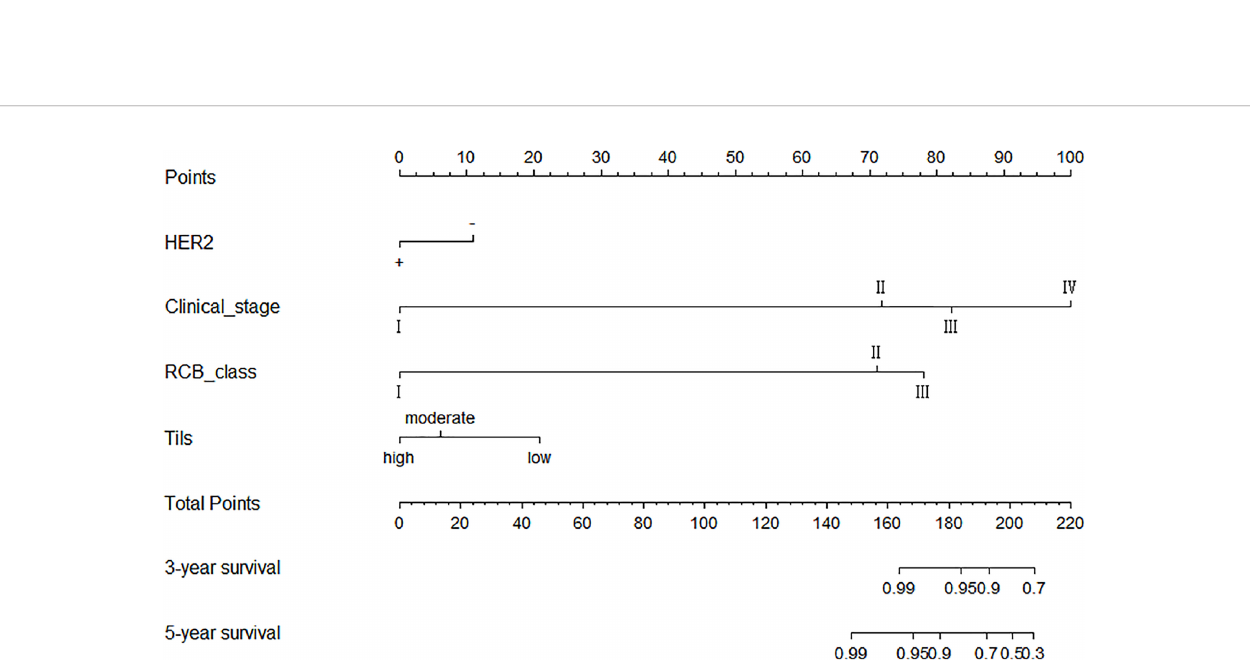
FIGURE 2 | Kaplan-Meier curve of different independent prognostic factors. Multivariate analysis showed that (A) clinical stage, (B) HER2, (C) RCB grading, and (D) Tils were correlated with OS in non-PCR patients after neoadjuvant therapy for breast cancer.